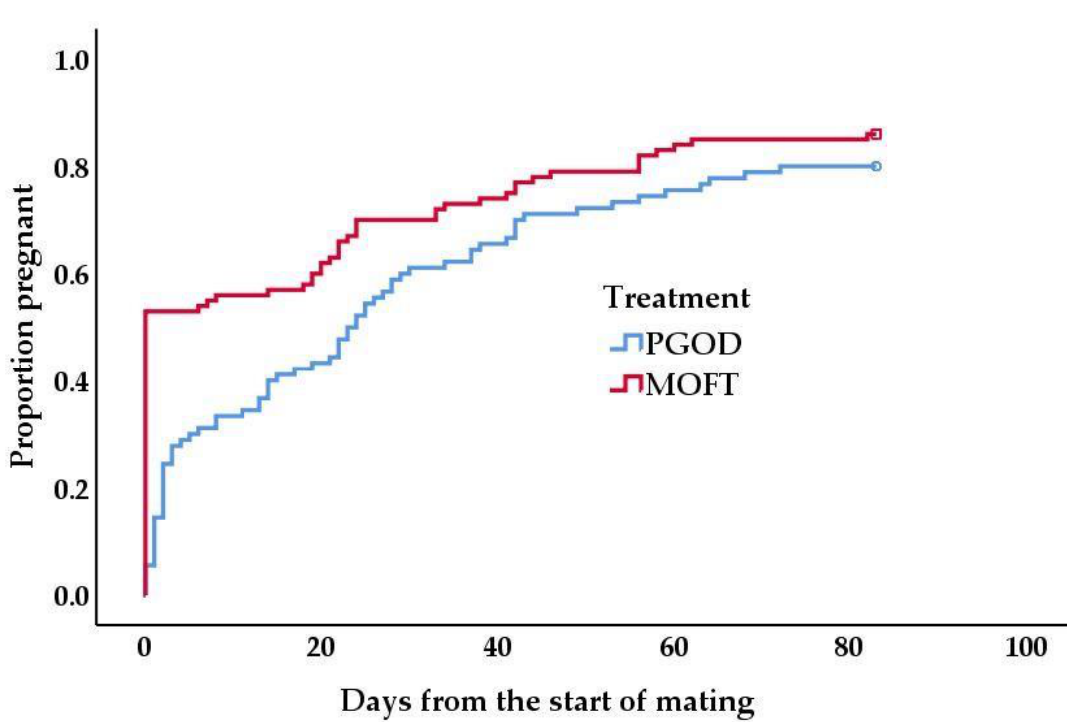
Figure 2. Kaplan–Meier analysis of cumulative pregnancy (1—survival) for: (i) red line, MOFT; (ii) blue line, PGOD. Log-rank testing identified a significant difference in survival distributions between treatment groups ( p = 0.03). Survival analysis was recorded for a duration of 84 days and cows that had not conceived or had not been inseminated by this time were right censored as displayed by a: (i) red square, MOFT; (ii) blue circle,